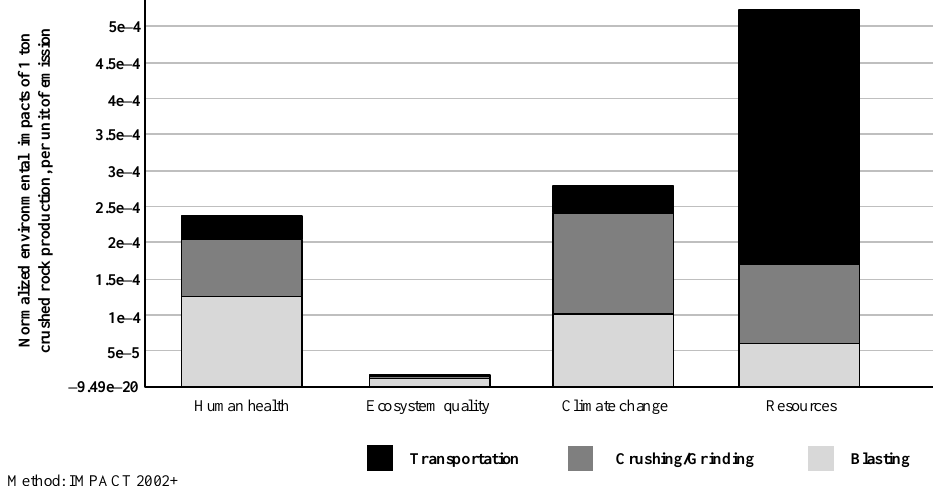
Fig. 7. Normalized environmental impacts of 1 ton crushed limestone rock production (LCIA: IMPACT